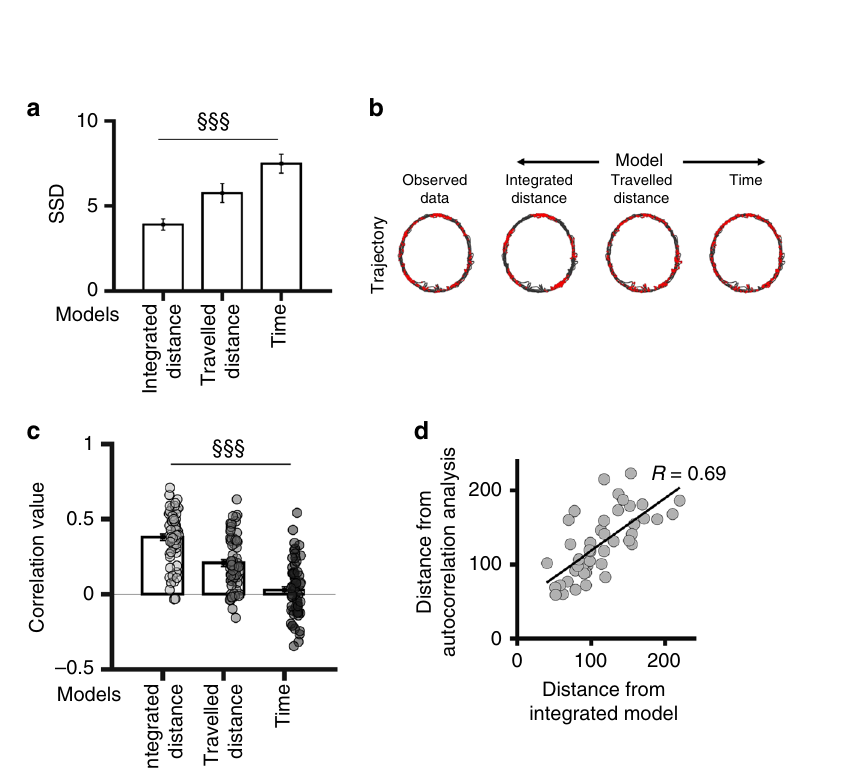
Fig. 3 Grid cell regularity is based on path integrated distance — autocorrelation analysis. a Activity of one grid cell recorded in the arena (top) and in the circular track (bottom), with peak fi ring rate and gridness score ( ‘ g ’ ). b First row: activity of the grid cell (from panel a — track) linearized according to the path integrated distance ( fi rst column), the travelled distance (second column) and the time (third column). Second row: autocorrelation. Third row: Toeplitz matrix of the fi rst 500 centimeters (corresponding to a complete lap). The color-coded matrix reveals regularity only for the path integrated distance. c Distribution of the average value of the fi rst two peaks in the autocorrelation for all grid cells (Observed), as well as shuf fl ed distribution obtained by resampling spike times from the same cells with a jitter procedure (Jitter; 400 permutations). Red lines indicate the ninety-ninth percentile for the shuf fl ed data. d , e Distribution of the average value of the fi rst two peaks in the autocorrelation of the linearized grid cell activity according to travelled distance ( d ) or time ( e ). Red lines indicate the ninety-ninth percentile for the shuf fl ed data. Only one grid cell showed autocorrelation value above the statistical threshold, exclusively for the travel distance. f – h Example of one grid cell showing allocentric coding. f Activity of the cell in the arena (top) and the track (bottom). g Linearized fi ring activity ( fi rst row) of the cell according to the three distance models, autocorrelation (second row) and Toeplitz matrix. h Color-coded rate map of the cell activity linearized in relation to the track position (top row), and rate plots of the fi ring activity across four laps; note that the position of the fi ring fi elds is consistent with the allocentric fi ring model. i Average correlation (±SD) of grid cell activity across laps, according to the allocentric distance model (i.e. no shift between laps) for the 16 grid cells which do not show a path integrated distance fi ring and the 48 grid cells which show a path integrated distance fi ring. Data from individual cells are shown in grey. *** p < 0.005, paired